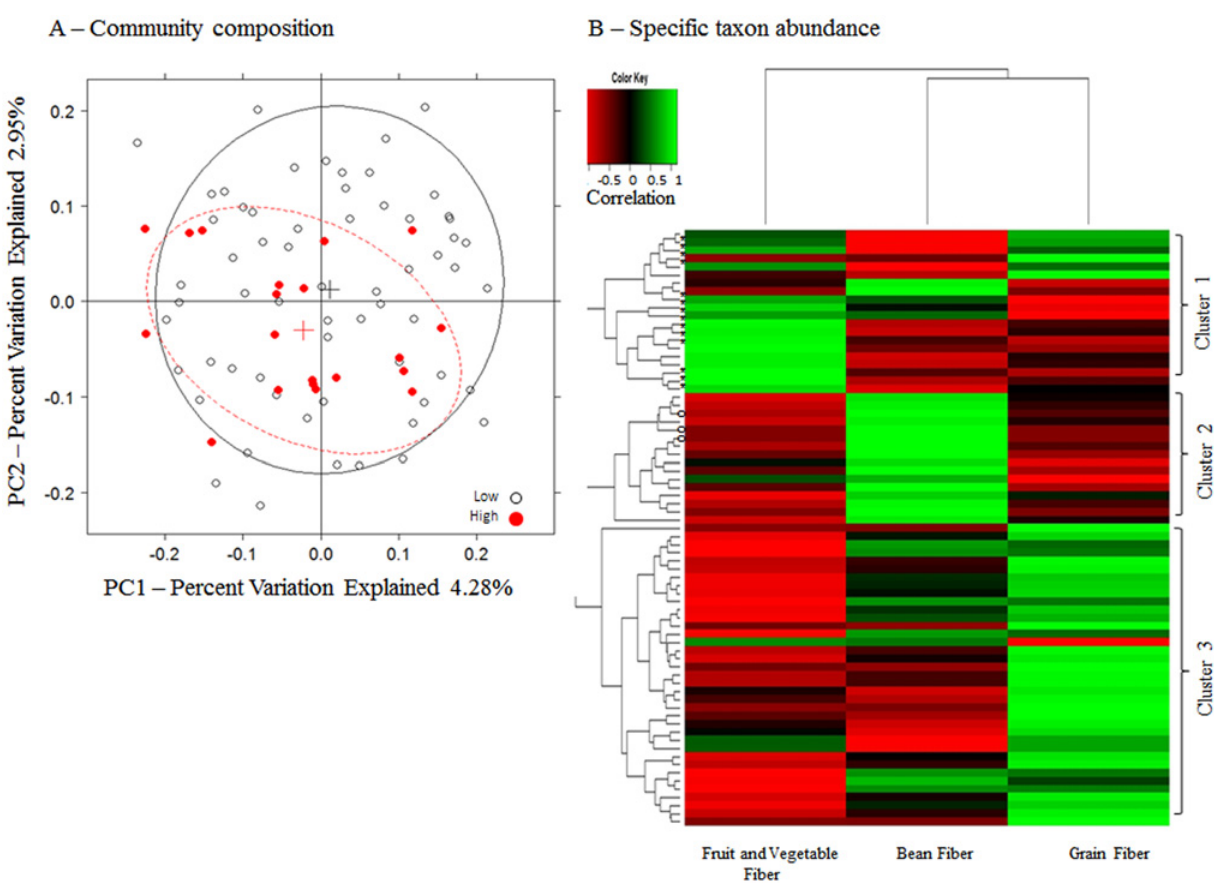
Fig 4. Gut microbiome according to dietary fiber intake. (A) Unweighted principal coordinate analysis plot of the first two principal coordinates categorized by fruit and vegetable fiber intake (Low: 1.6 – 11.7 g/day [equivalent to quartile 1 – 3], High: 11.7 – 21.9 g/day [quartile 4]). Ellipses were added to plots using the R package, latticeExtra (R version 2.15.3). (B) A heatmap based on unsupervised classification of Spearman correlations between the relative abundance of taxa (genus level) and three dietary fiber sources using the R package, gplots, (R version 2.15.3). For this analysis, only genera that were present in (cid:3) 15% of samples were included. Taxa belonging to Clostridia (Cluster 1, * ) and Bifidobacteriales (Cluster 2, ° ) are marked.